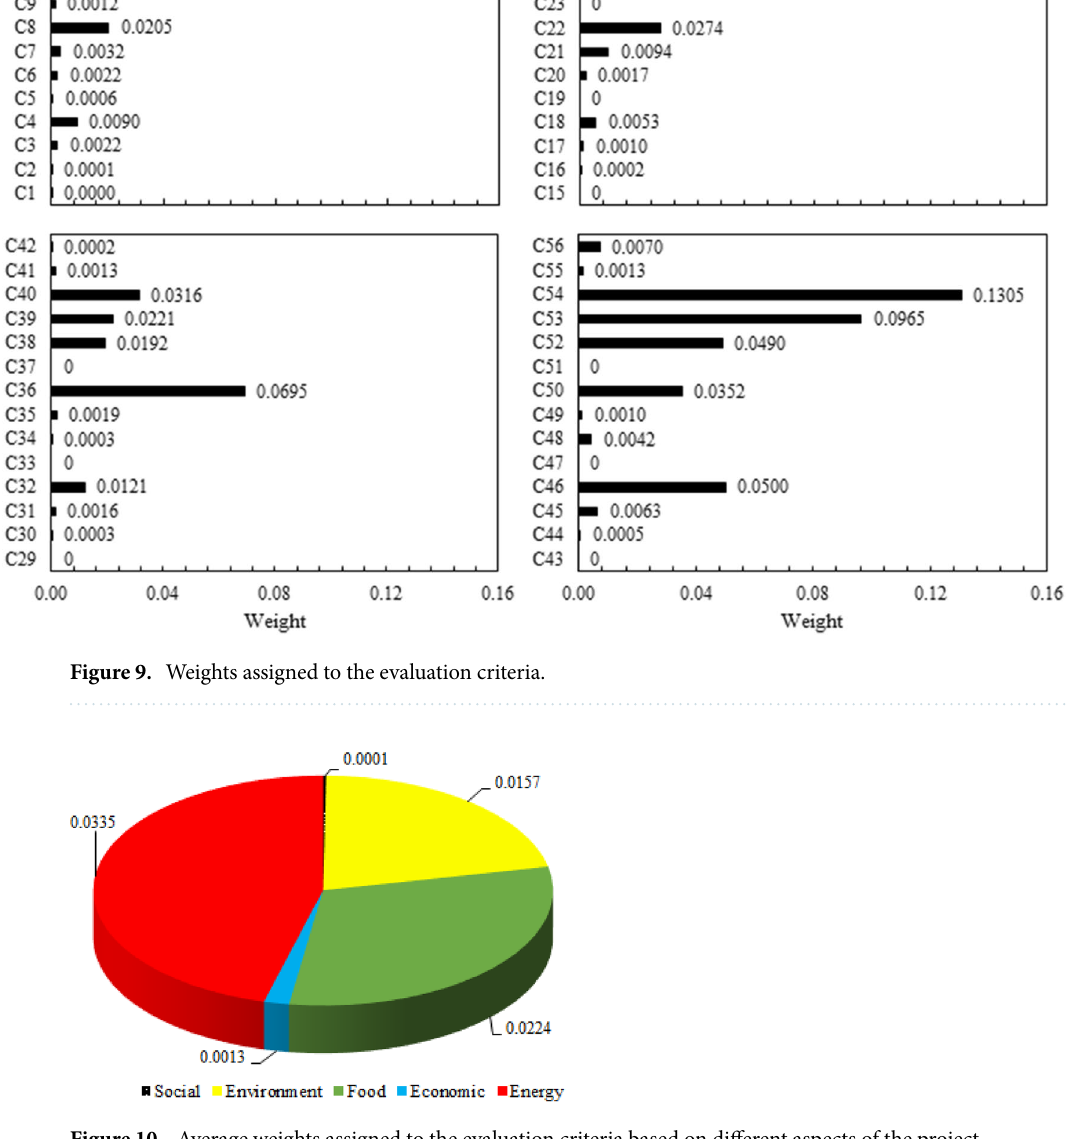
Figure 10. Average weights assigned to the evaluation criteria based on different aspects of the